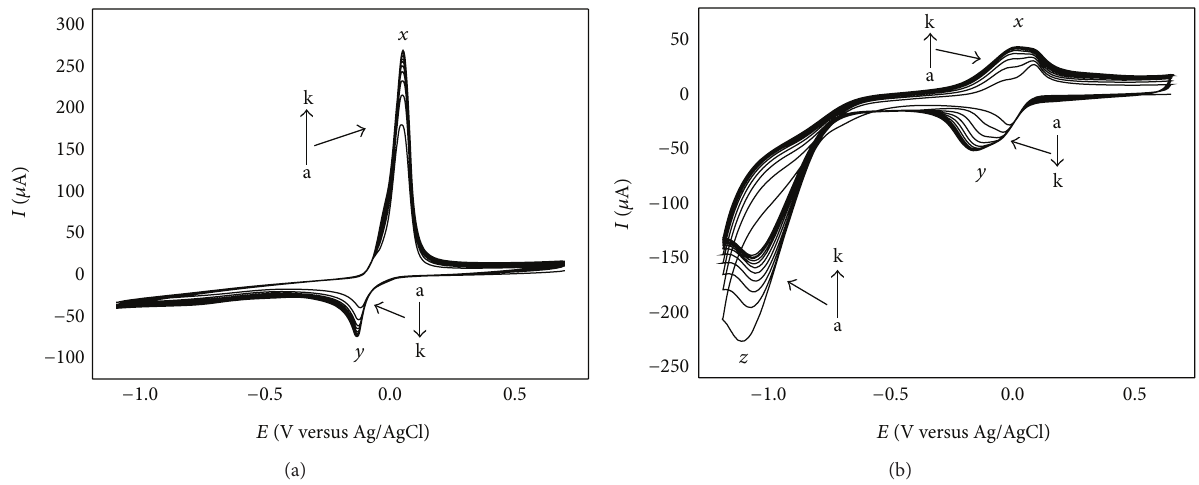
Figure 1: CVs of PMB/GCE (a) and PMB-ERGO/GCE (b) in the polymerization process at a scan rate of 0.10V ⋅ s −1 for 11 cycles (from a to k); 𝑥 : anodic peak of MB; 𝑦 : cathodic peak of MB; 𝑧 : cathodic peak of GO.